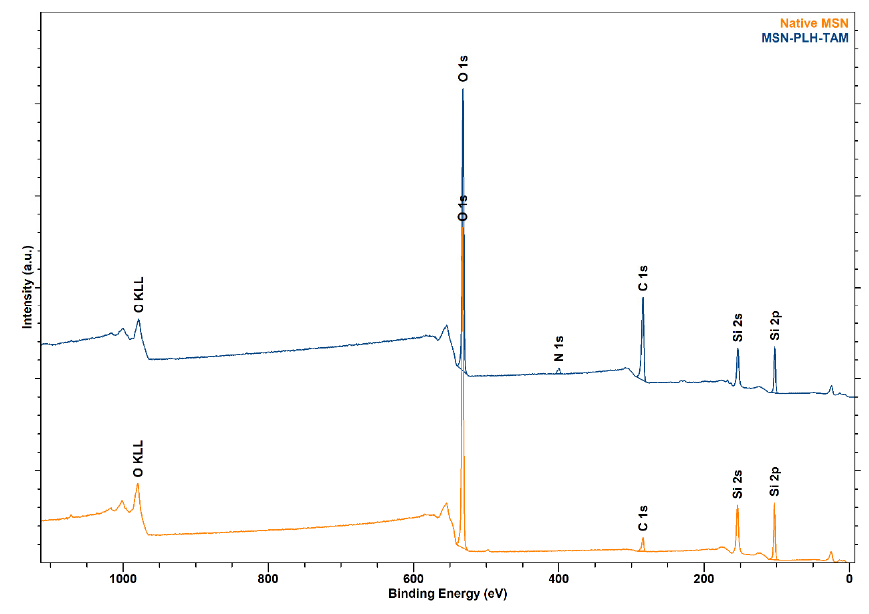
Figure 6. FT-IR spectra of MSN-PLH-TAM synthesized from the reaction between MSN-PLH (2) and TAM-TEG-OMs, via an S N 2 mechanism with mesylates as leaving groups. MSN-PLH-TAM demonstrated characteristic peaks of PLH and TAM molecules, including secondary amide C=O, aromatic C=C and di-substituted alkenes.